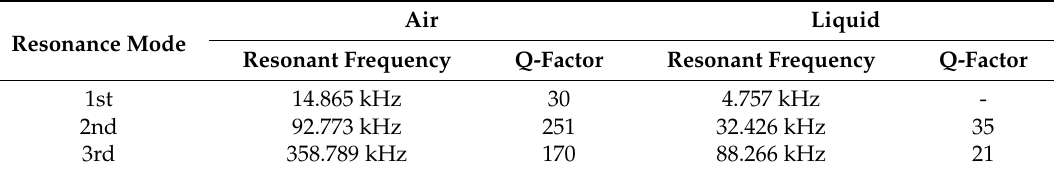
Table 1. First ~third resonance modes of resonant frequency in air and liquid